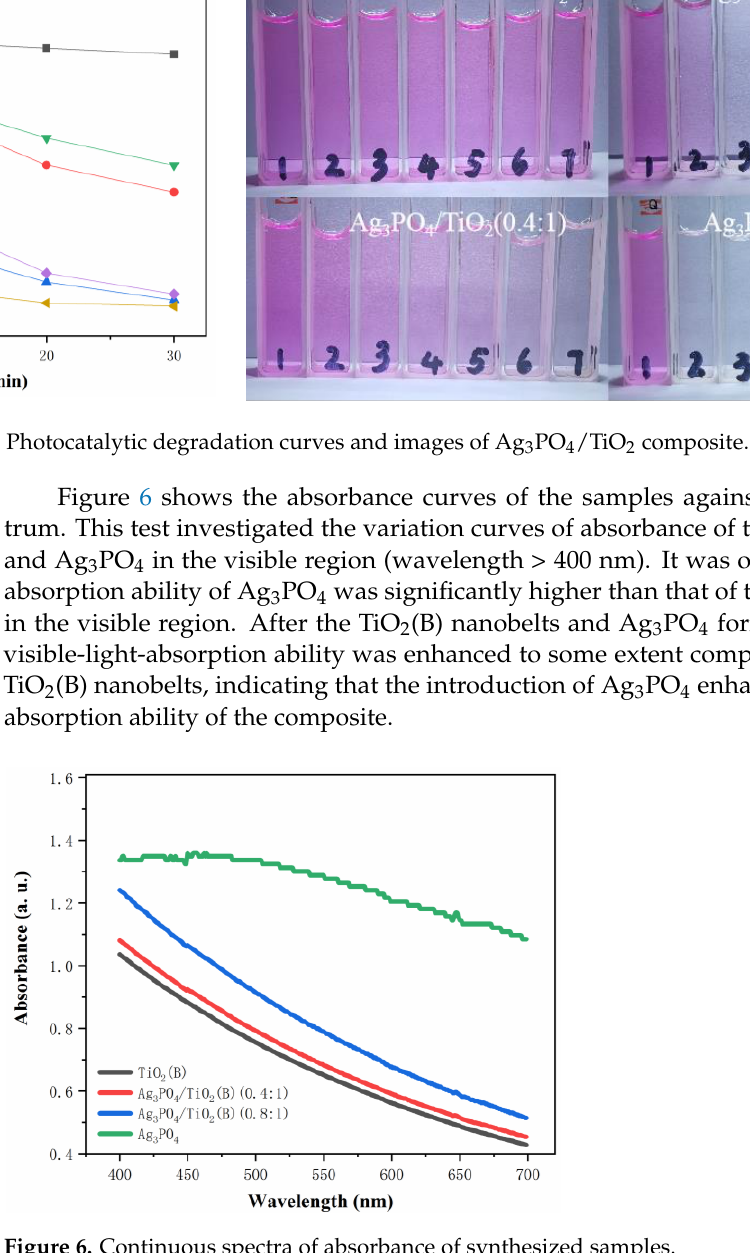
Figure 6. Continuous spectra of absorbance of synthesized samples.